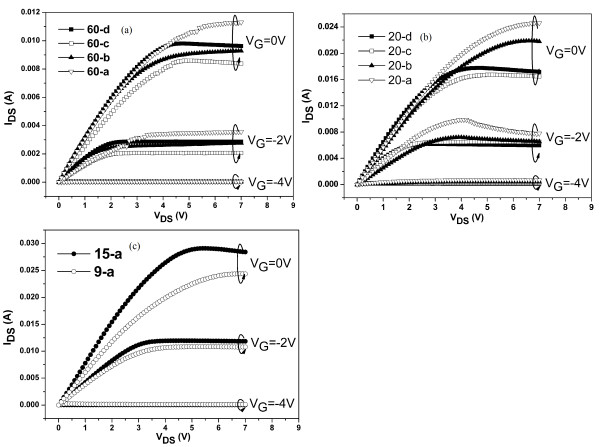
MeasuredI-Vcurves at room temperature for samples with different drain-to-source distances. 60 (a), 20 (b), and 15 and 9 μm (c).